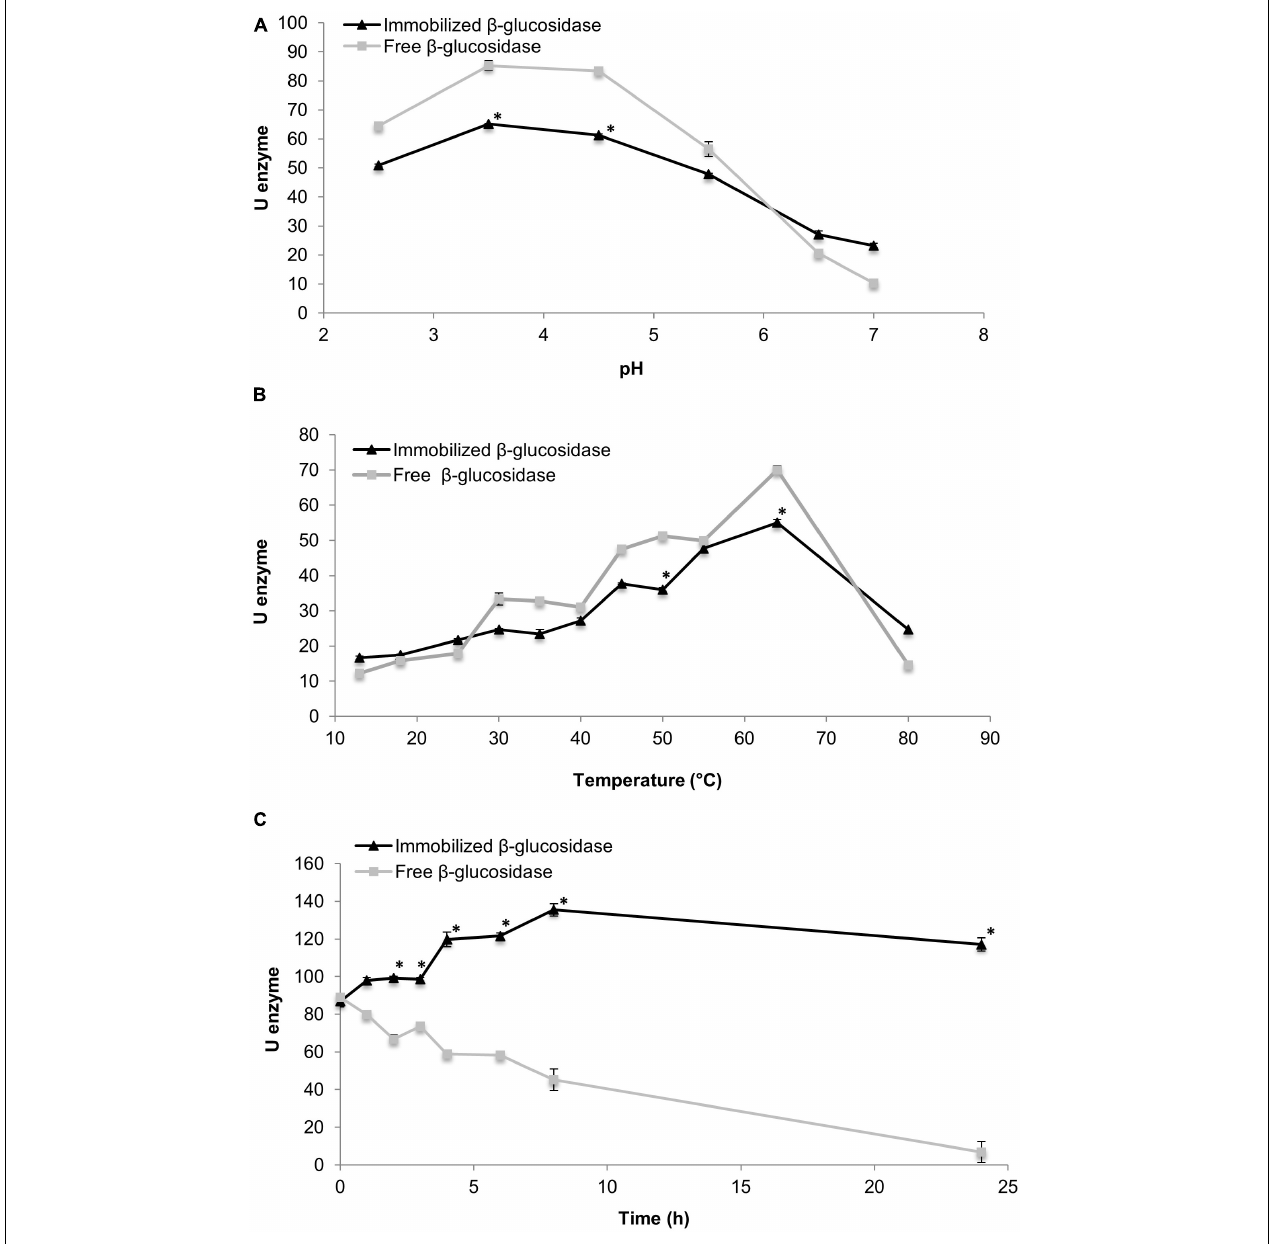
FIGURE 1 | Effect of pH (A) and temperature (B) values on the activity of free and immobilised β -glucosidase and their hydrolytic capability for 24 h (C) . * indicate significant differences between